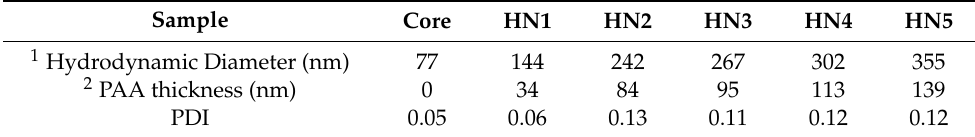
Table 3. Parameters of HNs with various PAA thicknesses.